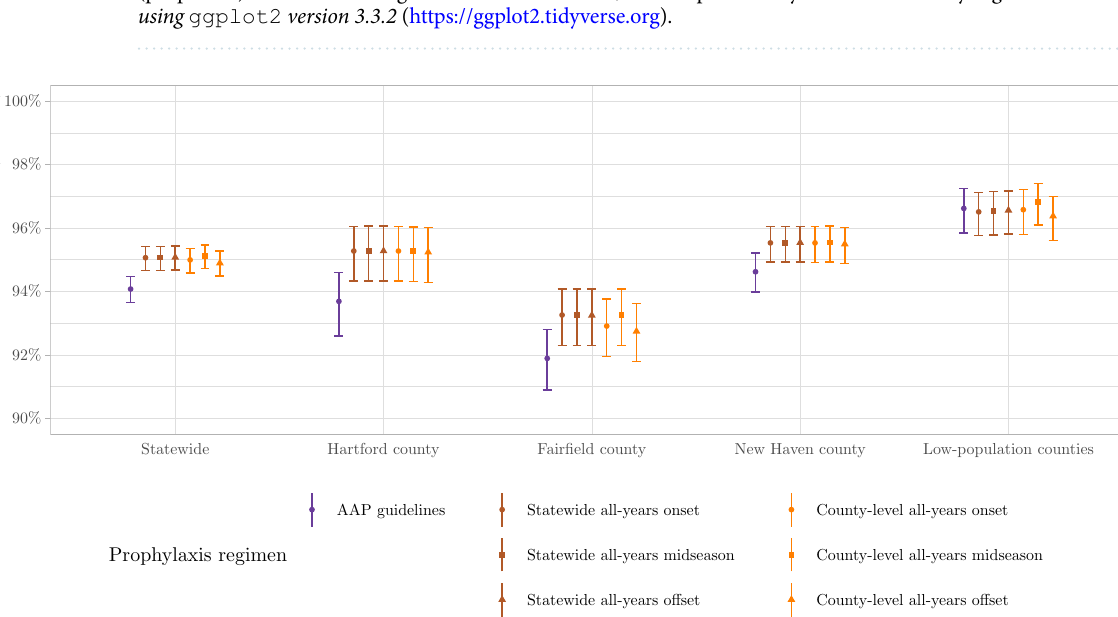
Figure 4. County-level variation in the relative timing of the RSV season in Connecticut and the AAP- recommended prophylaxis regimen. Comparison of the RSV season (red bar) and the prophylaxis window (purple bar) shows the misalignment between the two, notable particularly in Fairfield county. Figure created using ggplot2 version 3.3.2 (https:// ggplo t2. tidyv erse. org).